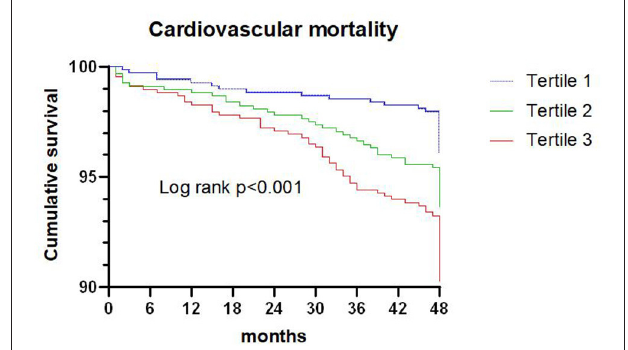
FIGURE 2 | Kaplan-Meier survival curve for cardiovascular death across triglyceride to high density lipoprotein-C ratio tertiles.